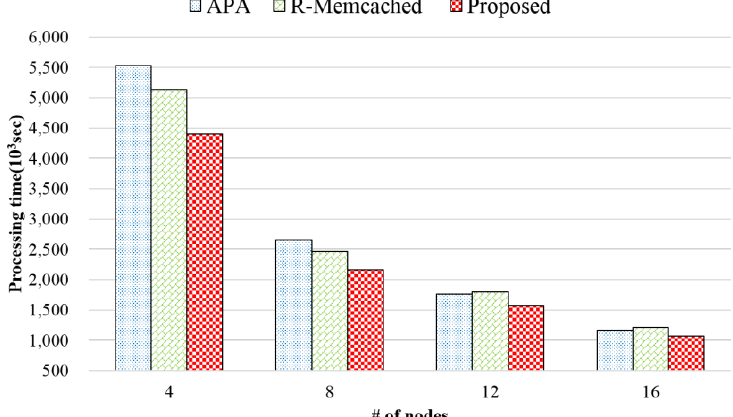
Figure 22. Query processing time according to the number of nodes.